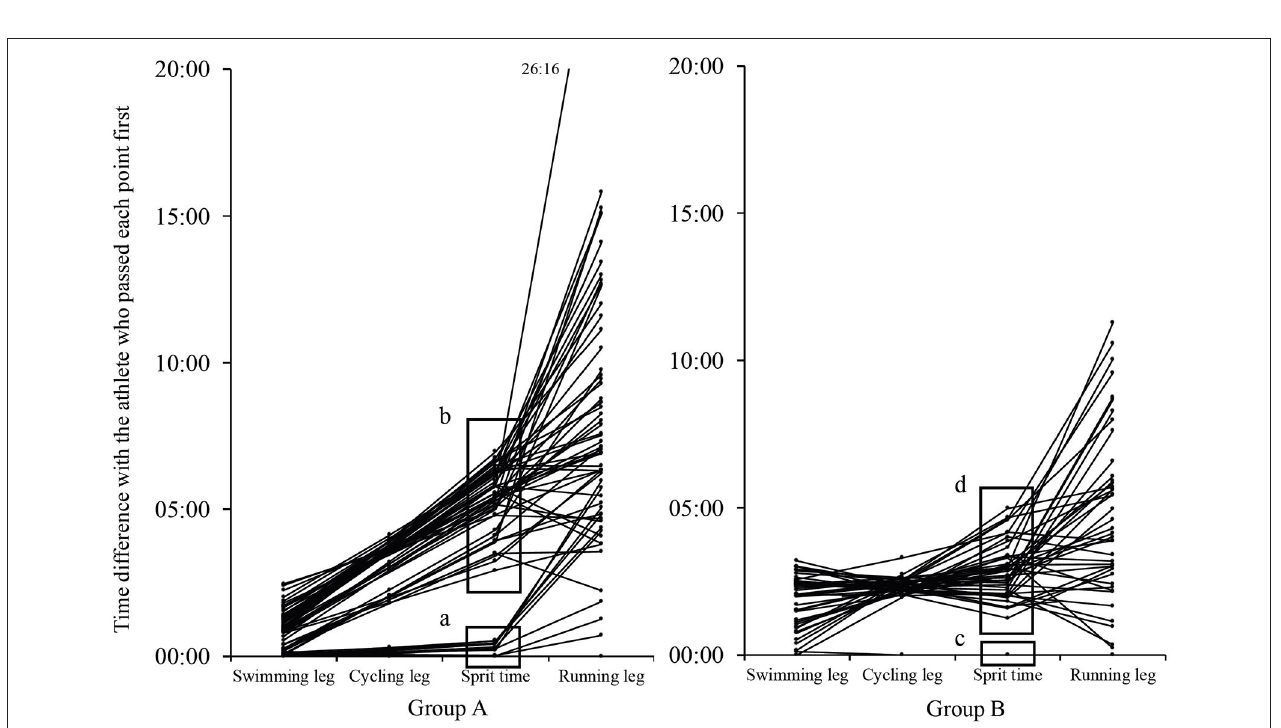
performance deteriorates as the pace becomes uneven and